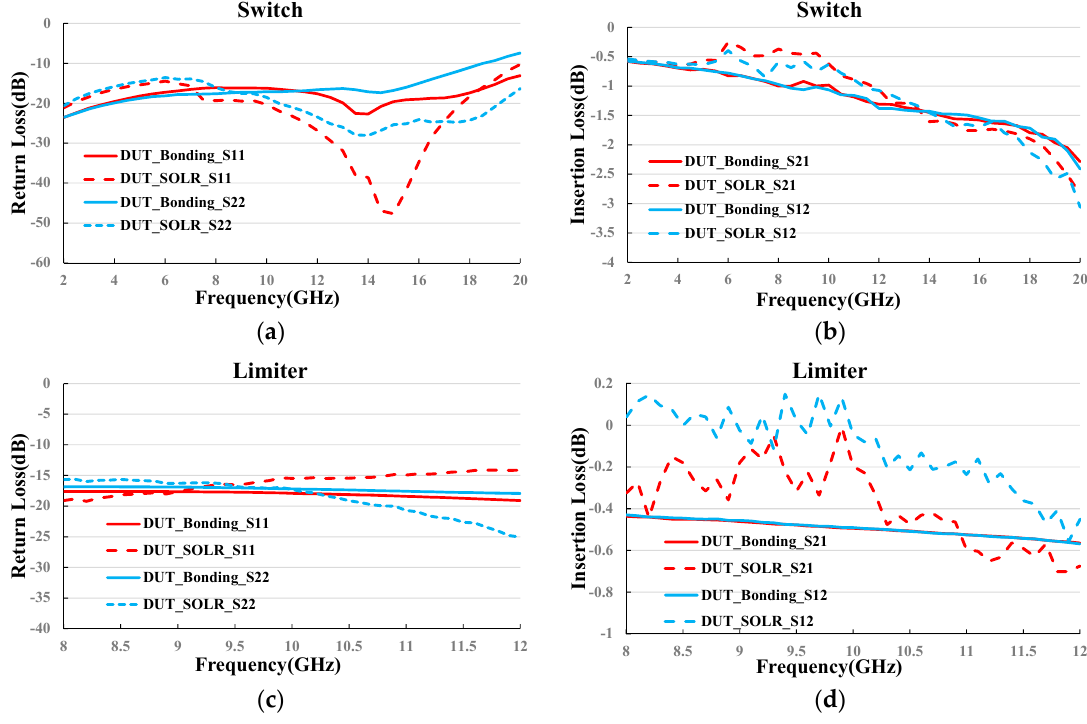
Figure 2. Comparison of the S ‐ parameters results between different methods, with ( a , b ) corresponding to return loss and insertion loss of switch, ( c , d ) corresponding to return loss and insertion loss of limiter.